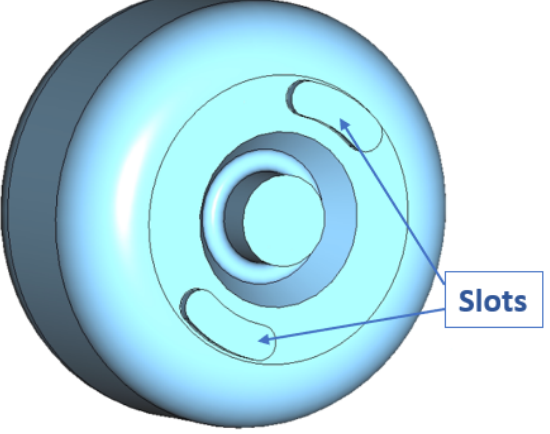
Figure 2. Slots located off axis for the electromagnetic coupling. A nose-cone structure was adopted to maximize the effective shunt impedance per unit length and efficiency of acceleration. The nose cone allowed for the concentration of